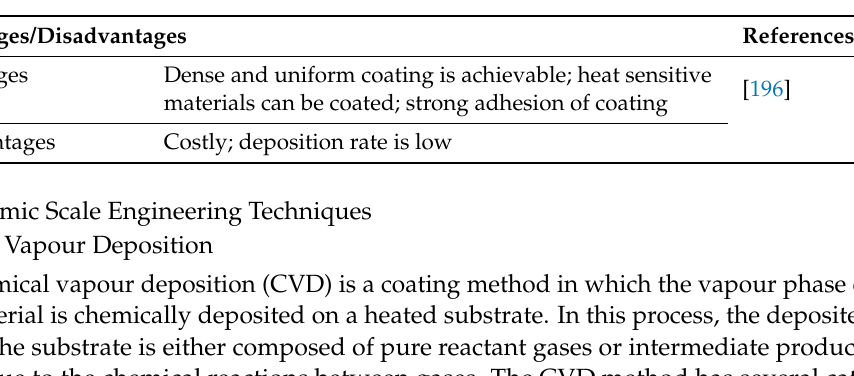
Table 13. Some of the significant advantages and disadvantages of radio frequency magnetron sputtering are mentioned in this